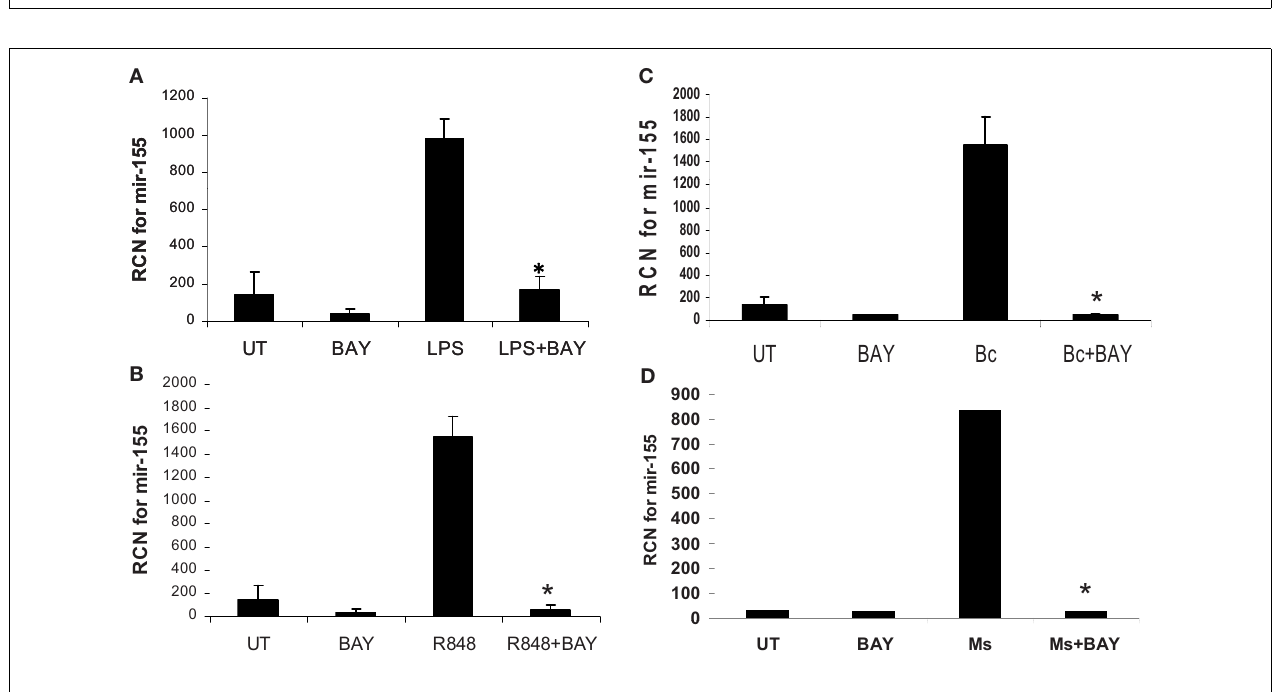
with (C) B. cenocepacia ( Bc ) at MOI 5, or (D) M. smegmatis ( Ms) at MOI 5. mRNA was isolated from the cells 16h later and assayed for miR-155 by qRT-PCR.These data are representative of six independent experiments. *Designates a p value <